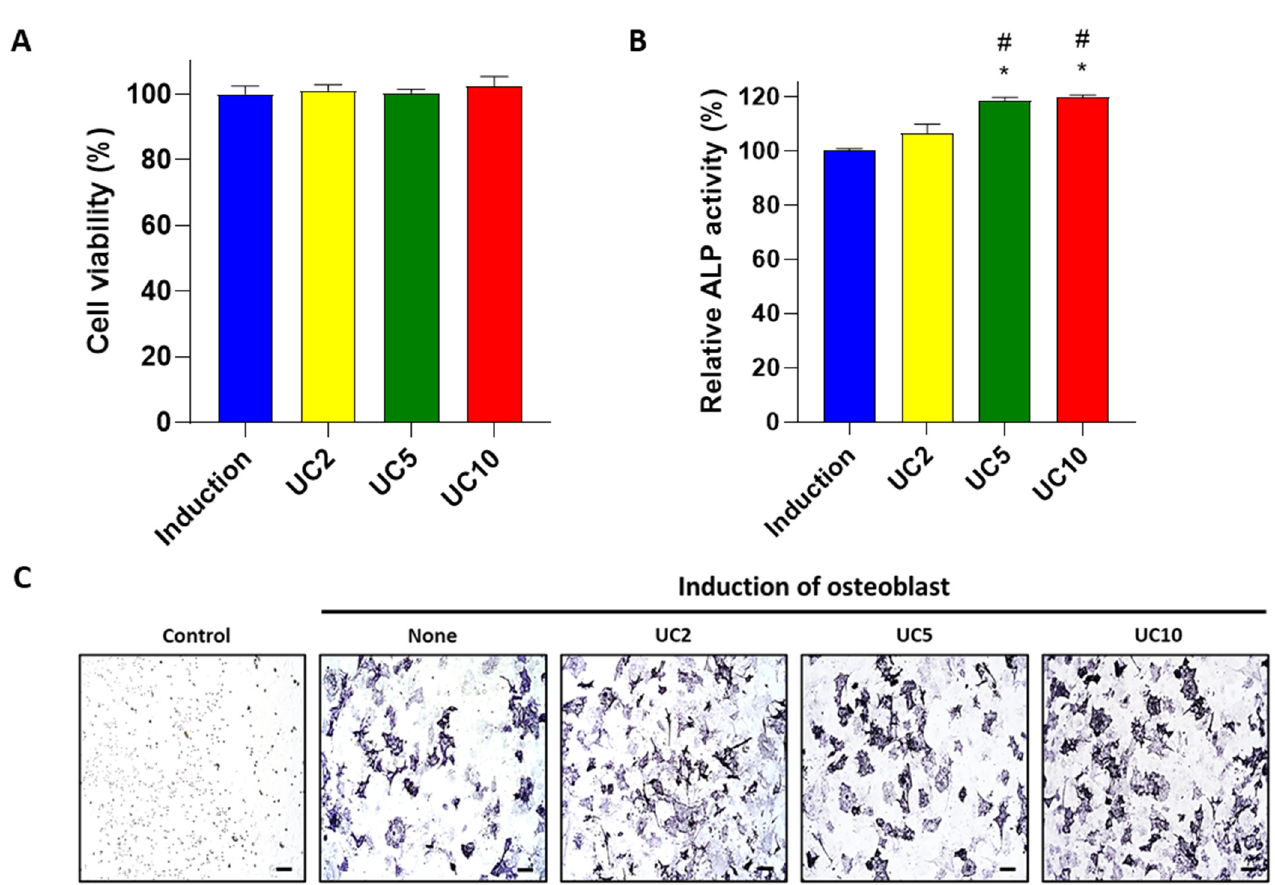
Figure 2. Effects of UC extract on osteoblast activity in primary osteoblasts. Primary osteoblastic cells were co-incubated with an osteoblast induction medium and different concentrations of UC 5:5 extract (2, 5 and 10 μ g/mL) for 3 days. ( A ) Cell viability and ( B ) ALP activity were evaluated. ( C ) ALP-stained cell images were obtained by light microscope. The results on the bar-graph are from three independent experiments. UC, Ulmus davidiana (UD) and Cornus officinalis (CO) 5:5 ratio treatment; * p < 0.05 vs. induction; # p < 0.05 vs. UC2 (one-way ANOVA with Tukey’s multiple comparison test).